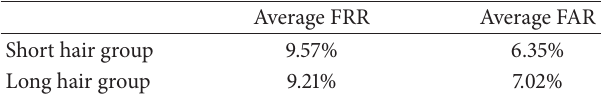
Table 5: Quantitative results of the algorithm with manually labeled hair style.